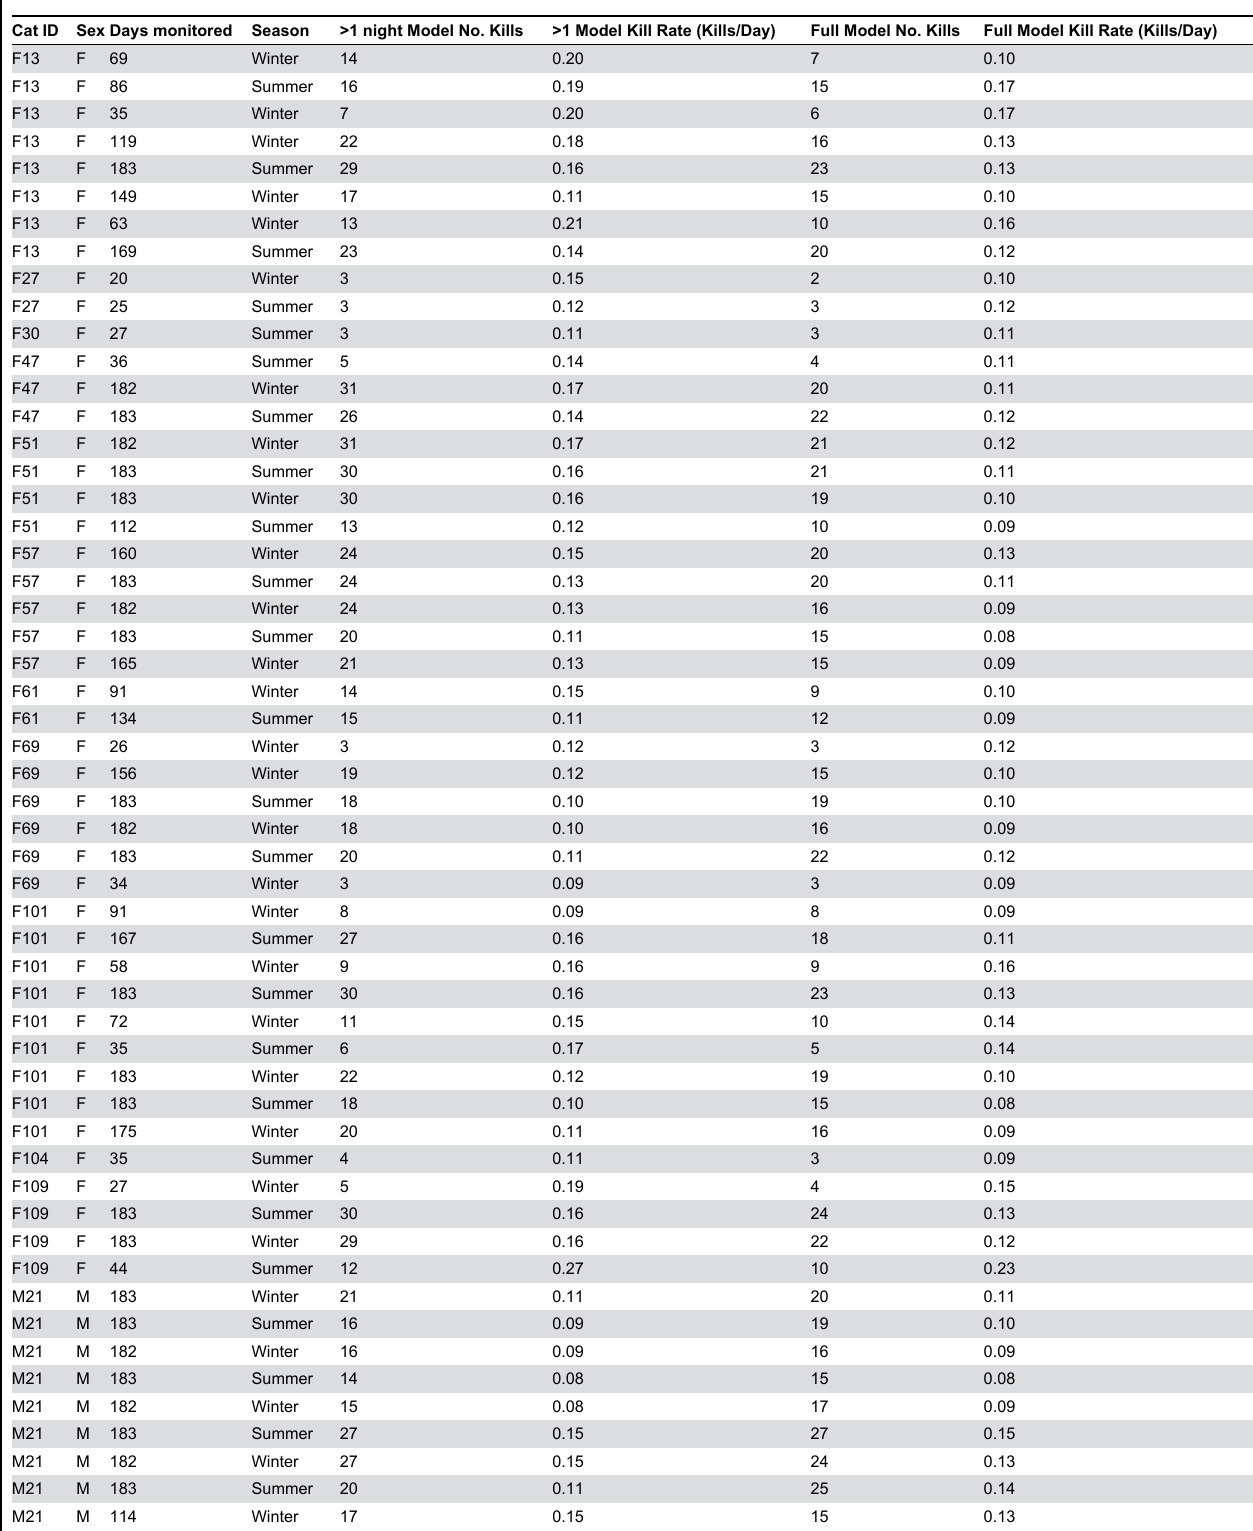
Cat ID Sex Days monitored